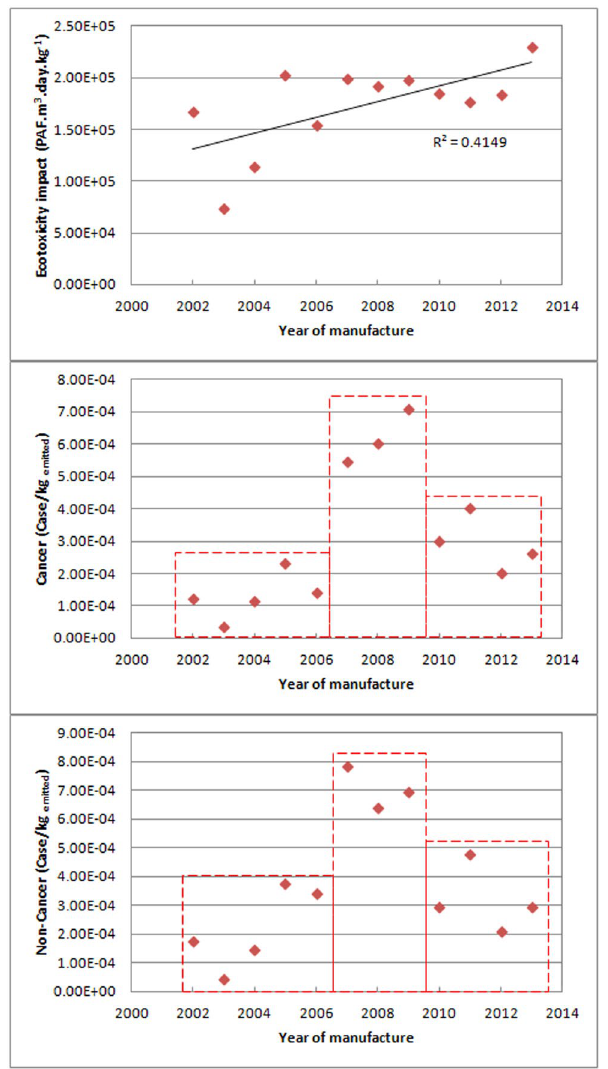
Figure 3. Potential impacts on ecotoxicity and human toxicity (carcinogenic and non- carcinogenic) from 2002 to